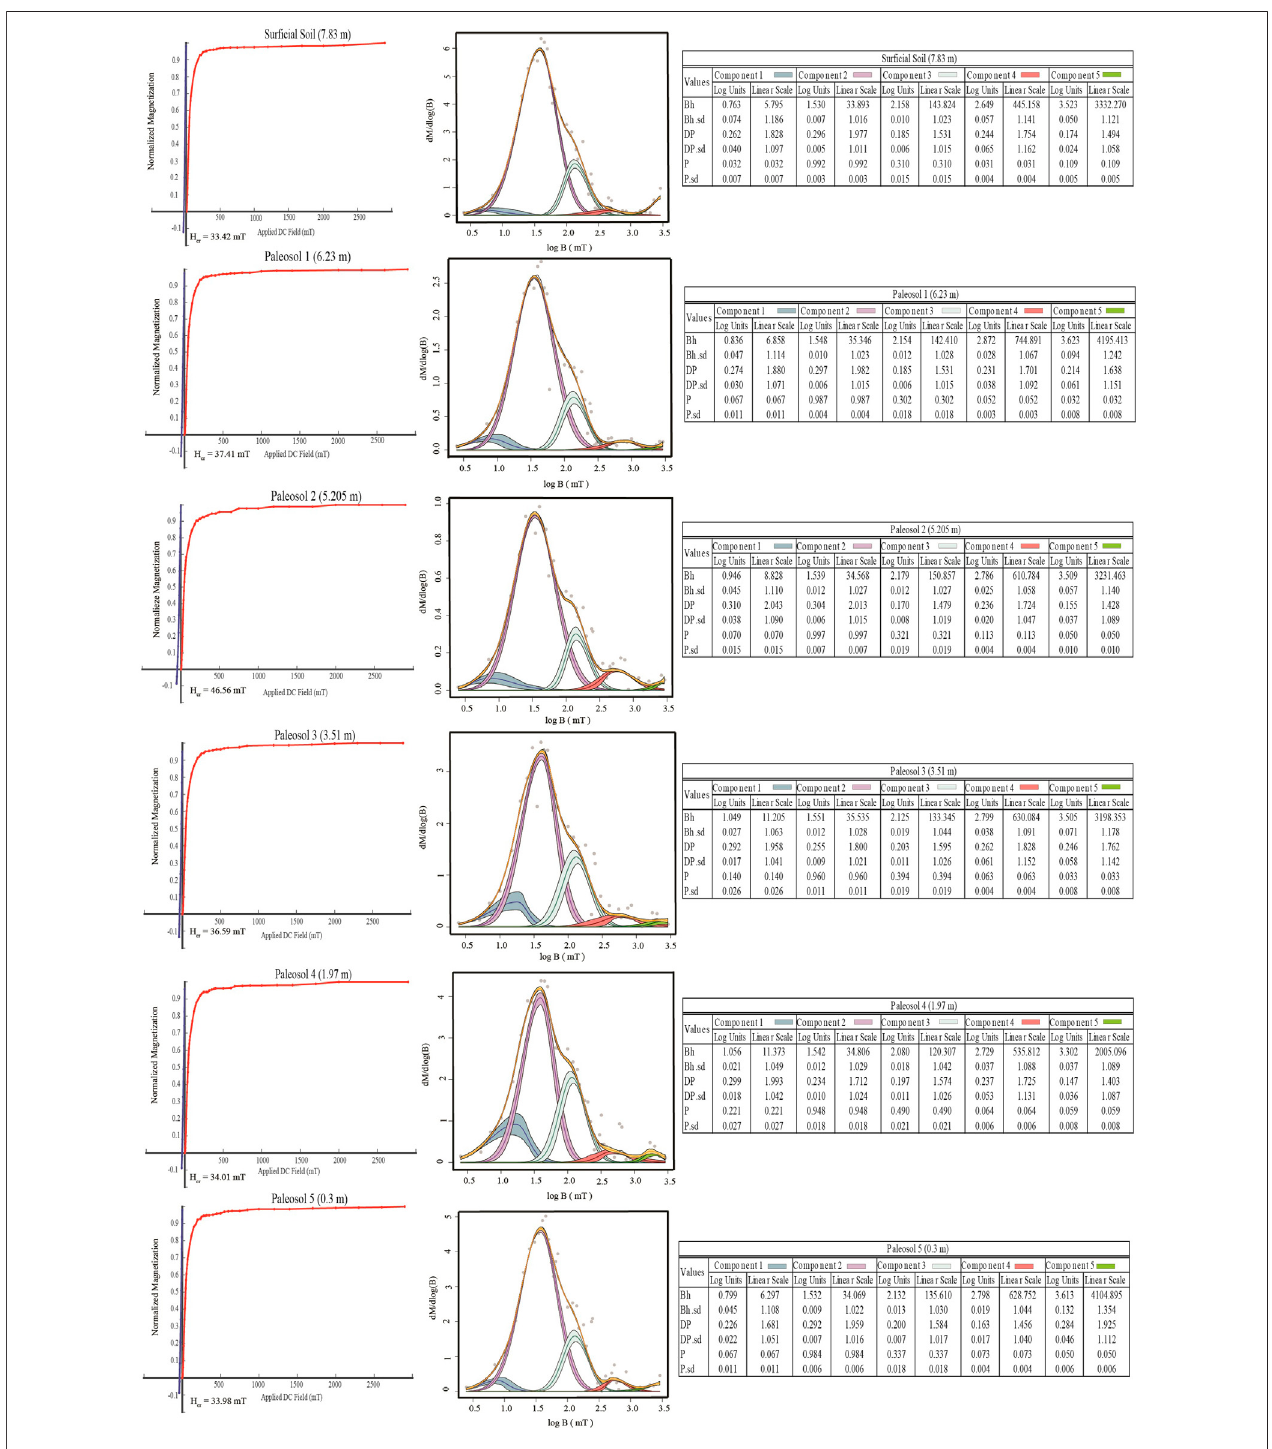
FIGURE 12 | Coercivity analysis for specimens from representative samples of all fi ve paleosols and the Sur fi cial Soil in the BDF. Left side for each sample: Curves showing the acquisition of an isothermal remanent magnetization (IRM) and back fi eld direct fi eld demagnetization of specimens. Right side for each sample: Corresponding magnetic component unmixing analysis results using the MAX UnMix protocol of (Maxbauer et al., 2016b) for IRM acquisition data. In terms of results of the unmixing analysis, Bh is the mean activating fi eld (coercivity) of each component grain population and Bh.sd the standard deviation. Dp is the dispersion parameter, de fi ned as one standard deviation in log space and Dp.sd the standard deviation. P is the optimum model parameter and P.sd the standard deviation. The IRM acquisition and back fi eld demagnetization data indicate the dominance of relatively low coercivity ferromagnetic phases in these intervals of the BDF and is